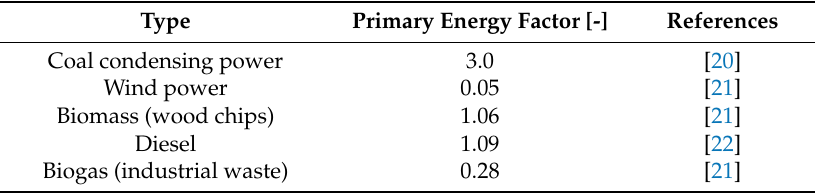
Table 1. Examples of conversion factors for primary energy.